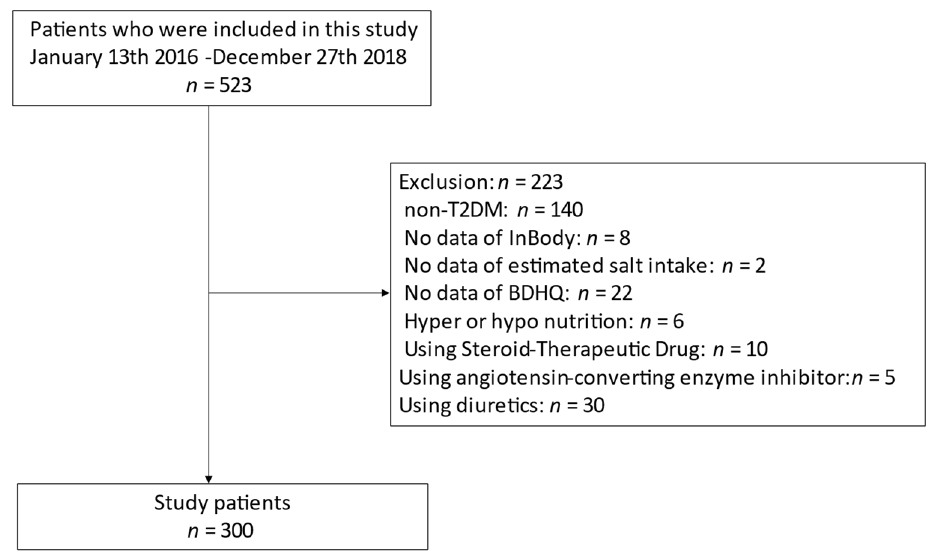
Figure 1. Inclusion and exclusion flow.